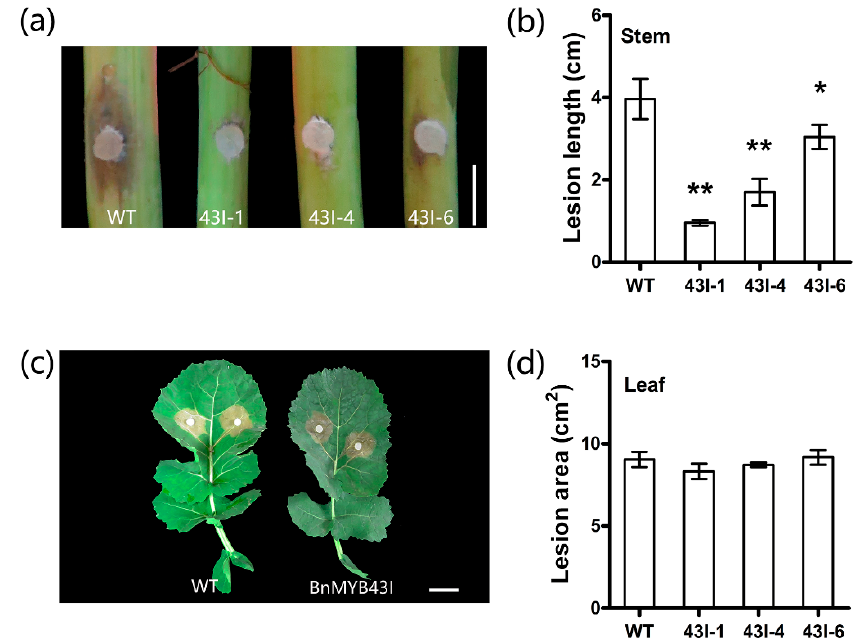
Figure 4. Phenotypic and lesion size of detached stems and leaves after inoculation with S. sclerotiorum . ( a , c ) The phenotypes of detached stems and leaves after inoculation with S. sclerotiorum , respectively. ( b ) The length of lesions in stem after inoculation with S. sclerotiorum for 96 h. ( d ) The area of lesions in leaf after inoculation with S. sclerotiorum for 48 h. Bars, 15 mm ( a ) and 30 mm ( c ). Values are means ± SD ( n = 3 biological replicates). Asterisks indicate significant differences from the control (*, 0.01 ≤ p < 0.05; **, p < 0.01) using one-way ANOVA.